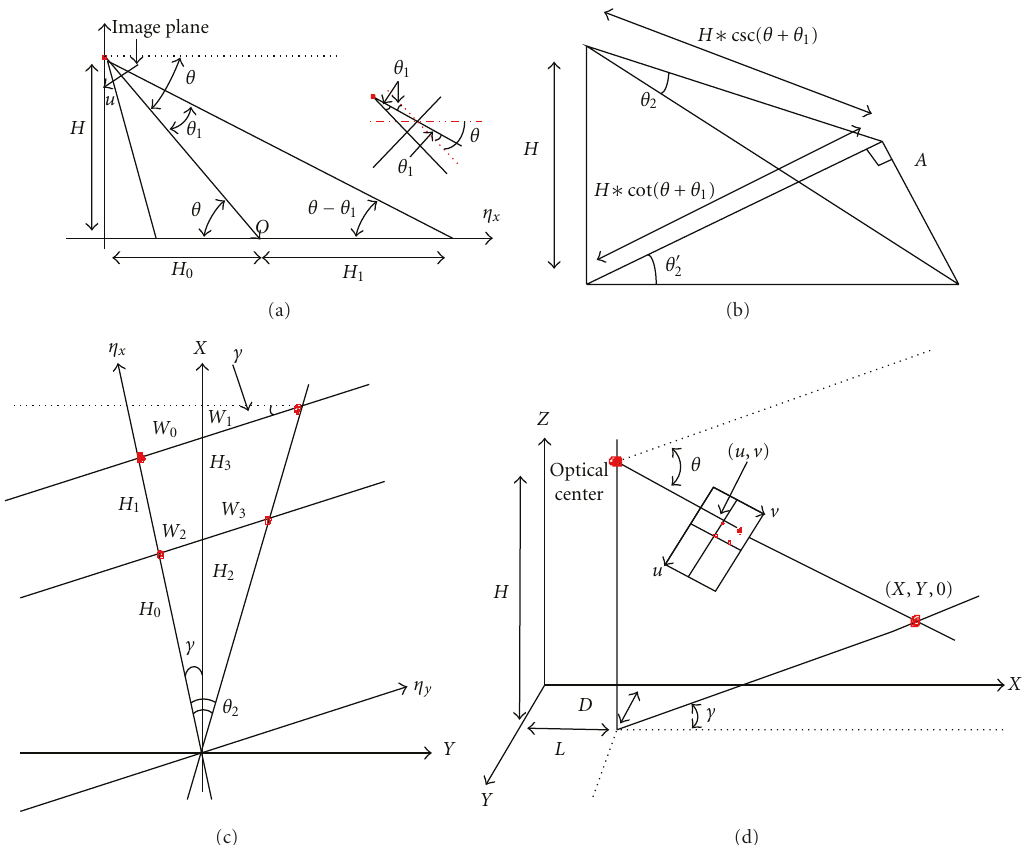
Figure 5: The geometrical relations of the image and world coordinate system for deriving our equations.